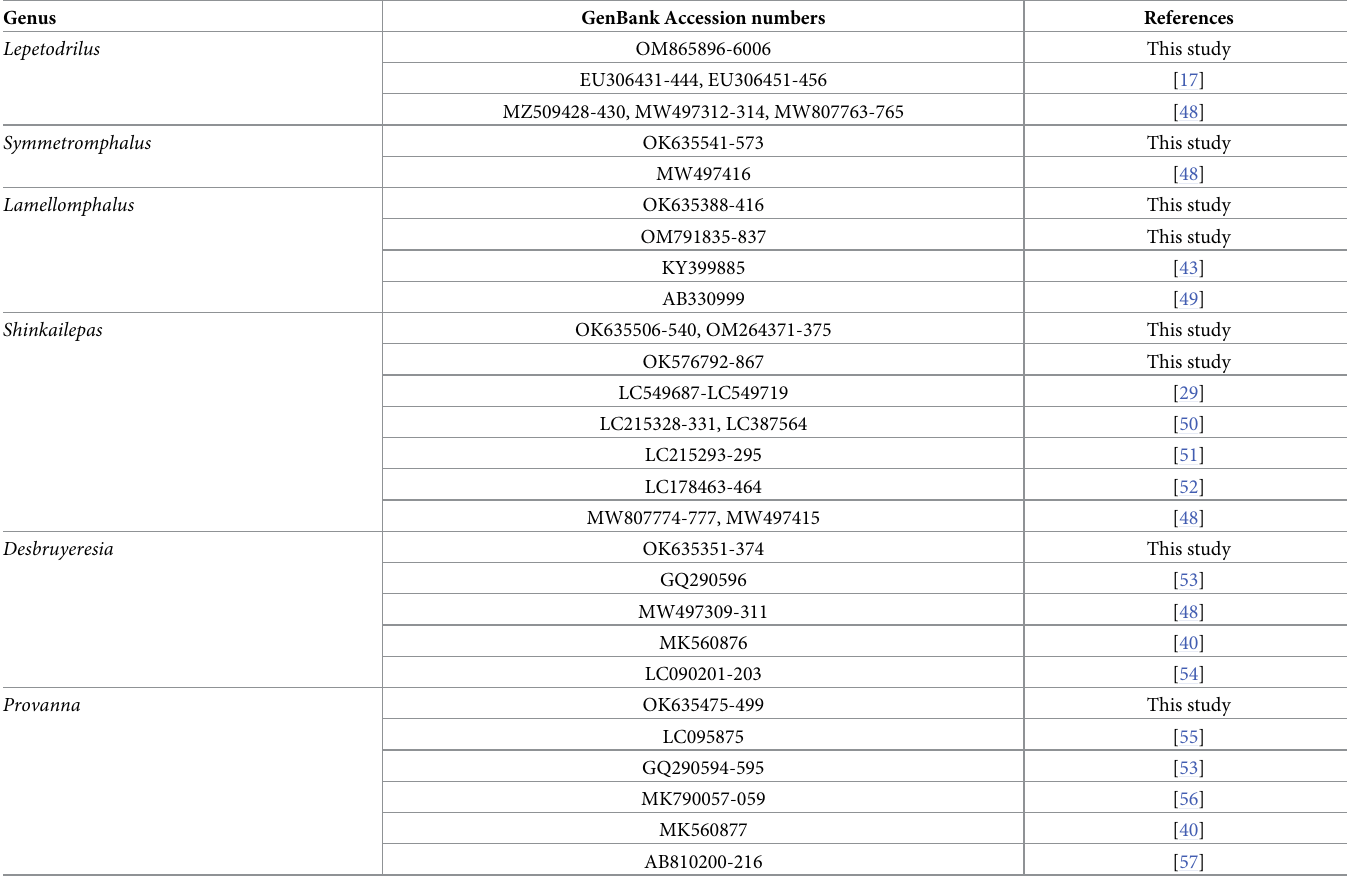
Table 3. List of accession numbers from gastropod individuals used for phylogenetic trees.